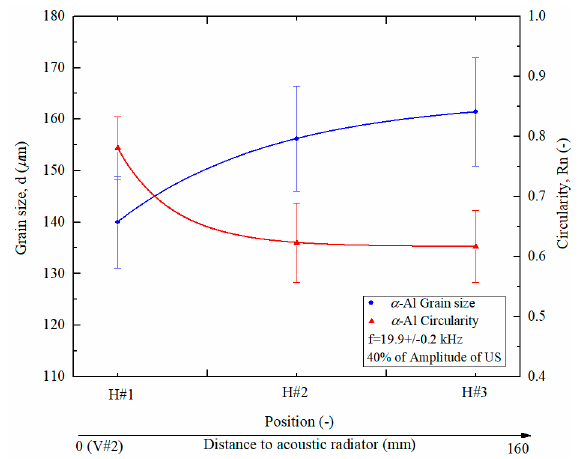
Figure 5. Variation of the α -Al grain size and circularity with the distance to the acoustic radiator in the feeder.